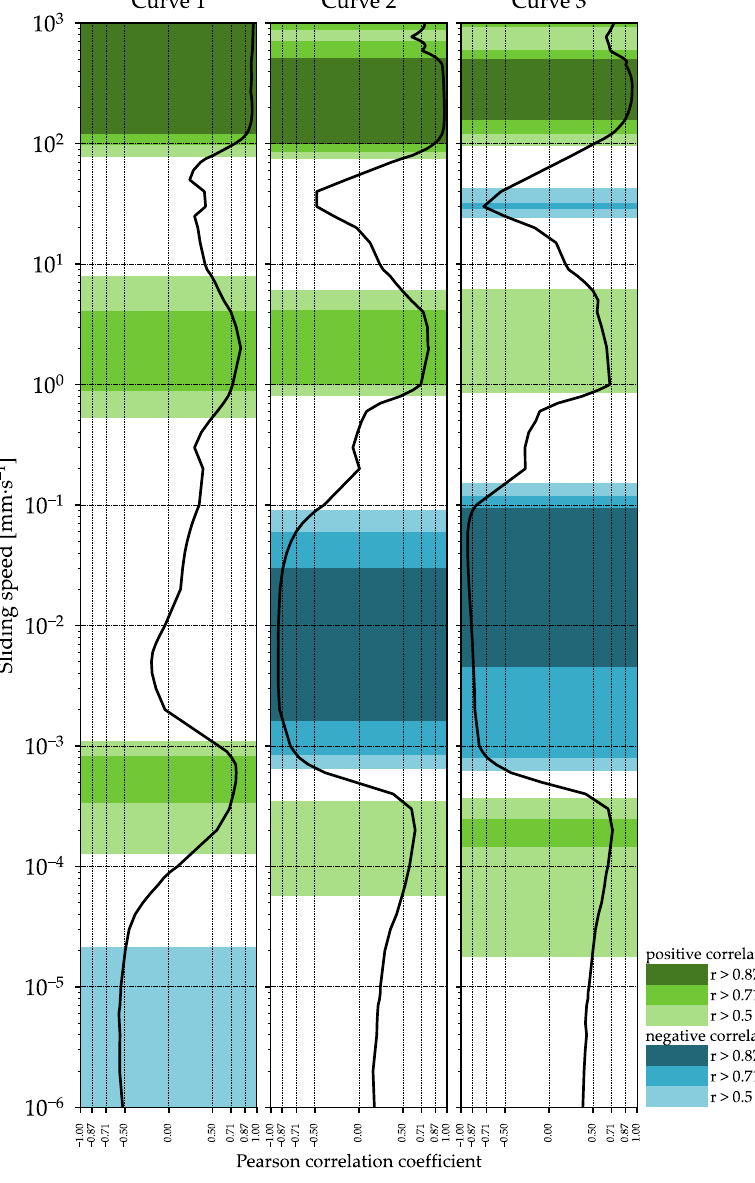
Figure 3. The Pearson correlation coefficient for the sensory attribute of stickiness and the coefficient of friction over the entire sliding speed range for all three curves of the tribological measurements.